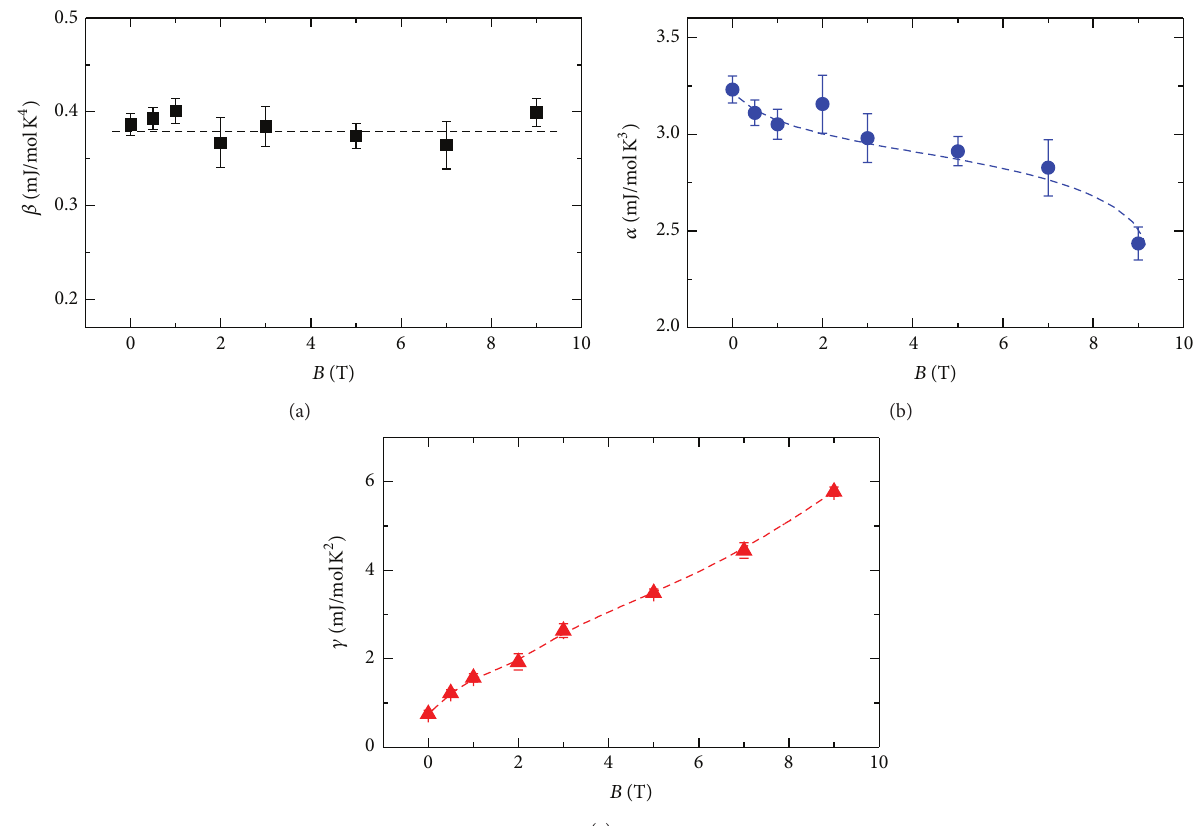
Figure 4: Field dependence (color online) of the fitting parameters 𝛽 and 𝛼 and 𝛾